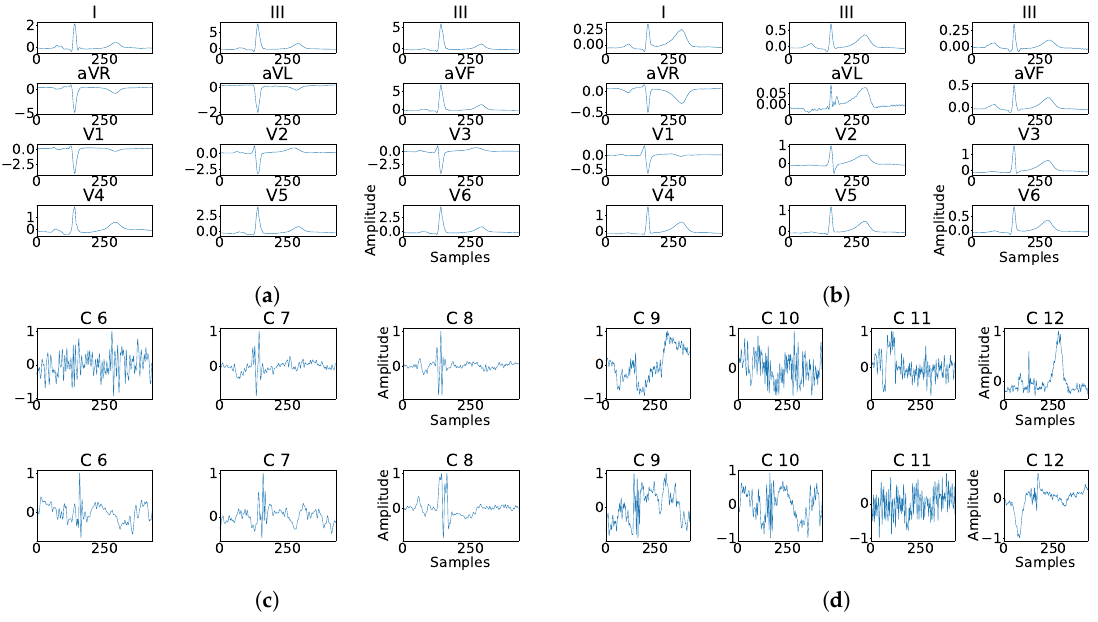
Figure 19. Example of fragmentation wave enhancement over real fragmented case. ( a ) Beat templates for each lead of real fragmented case. ( b ) Beat templates for each lead of control case. ( c ) Results of the best PCA method for the real fragmented case, in top subpanels and control case in bottom panels. ( d ) Results of the best ICA method for the real fragmented case, in top subpanels and for the control case in bottom panels.